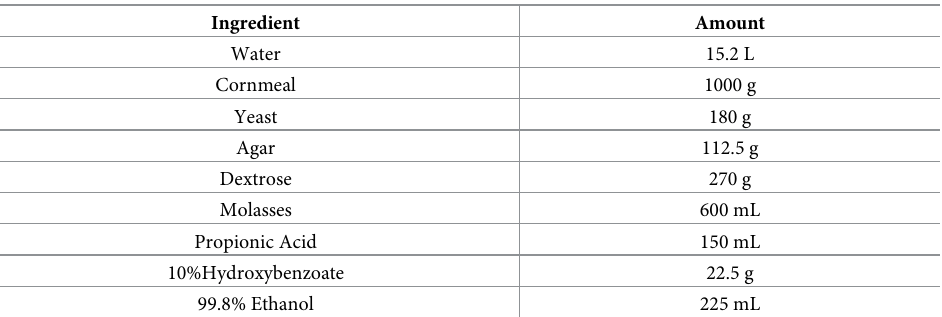
Table 1. Flyfood recipe.